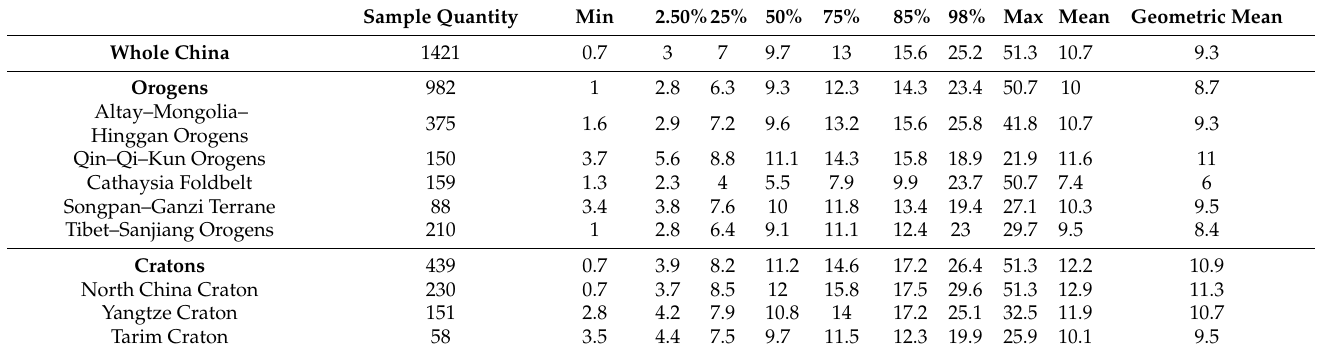
Table 3. Statistical parameters of cobalt abundance (mg/kg) of 1421 grids in different tectonic units. Sample